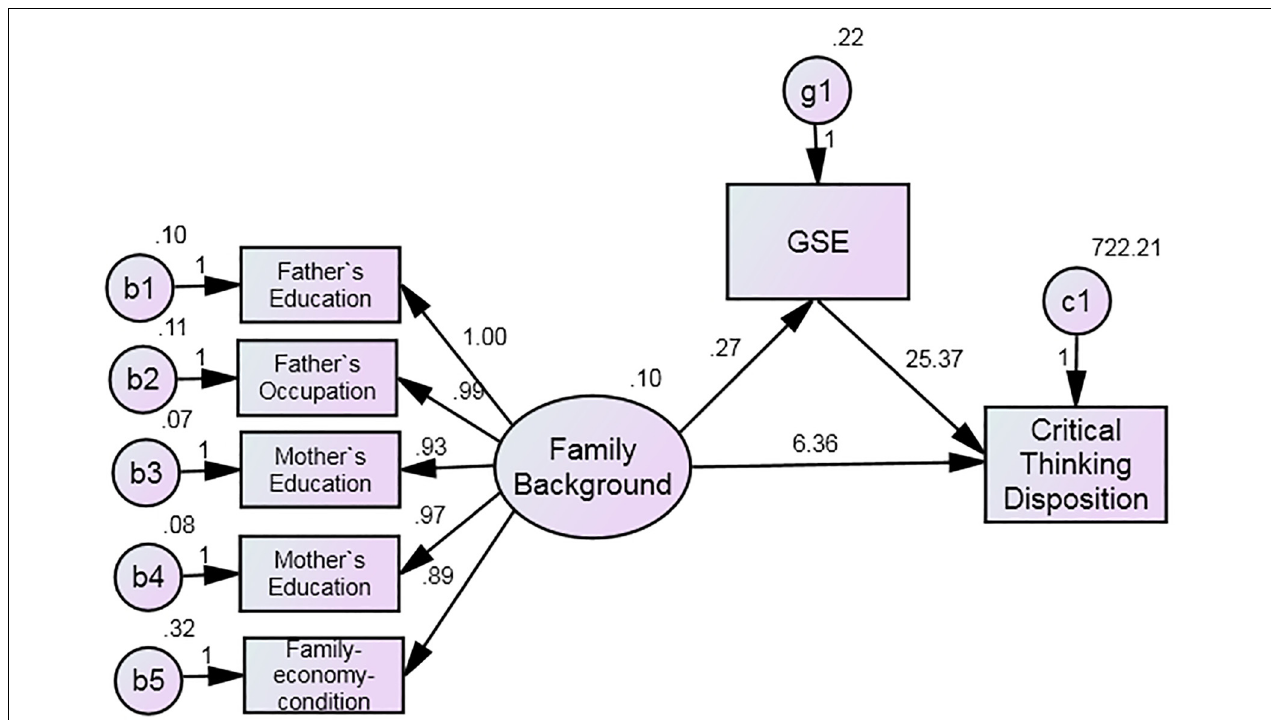
FIGURE 1 | Hypothesized SEM of the possible relationships among family SES, GSE, and